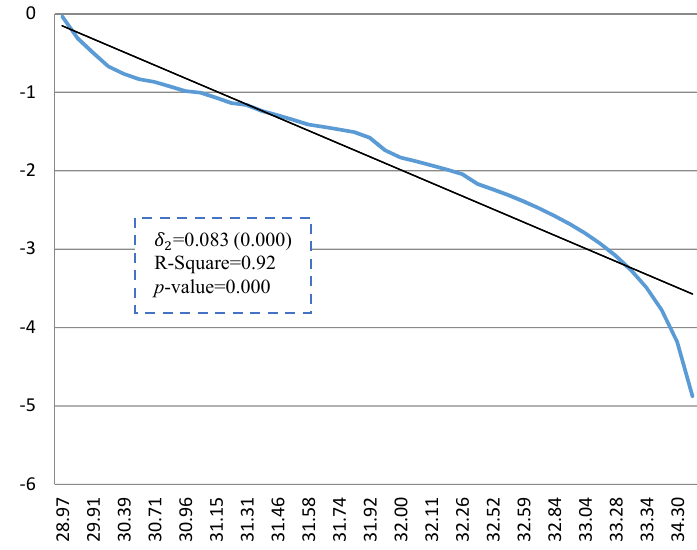
Figure 9. Cumulative distribution of V (cid:2919)(cid:2924)(cid:2930) , P (cid:2919)(cid:2924)(cid:2930) , s (cid:3037)(cid:2919)(cid:2924)(cid:2930) and H (cid:3036)(cid:2919)(cid:2924)(cid:2930) .